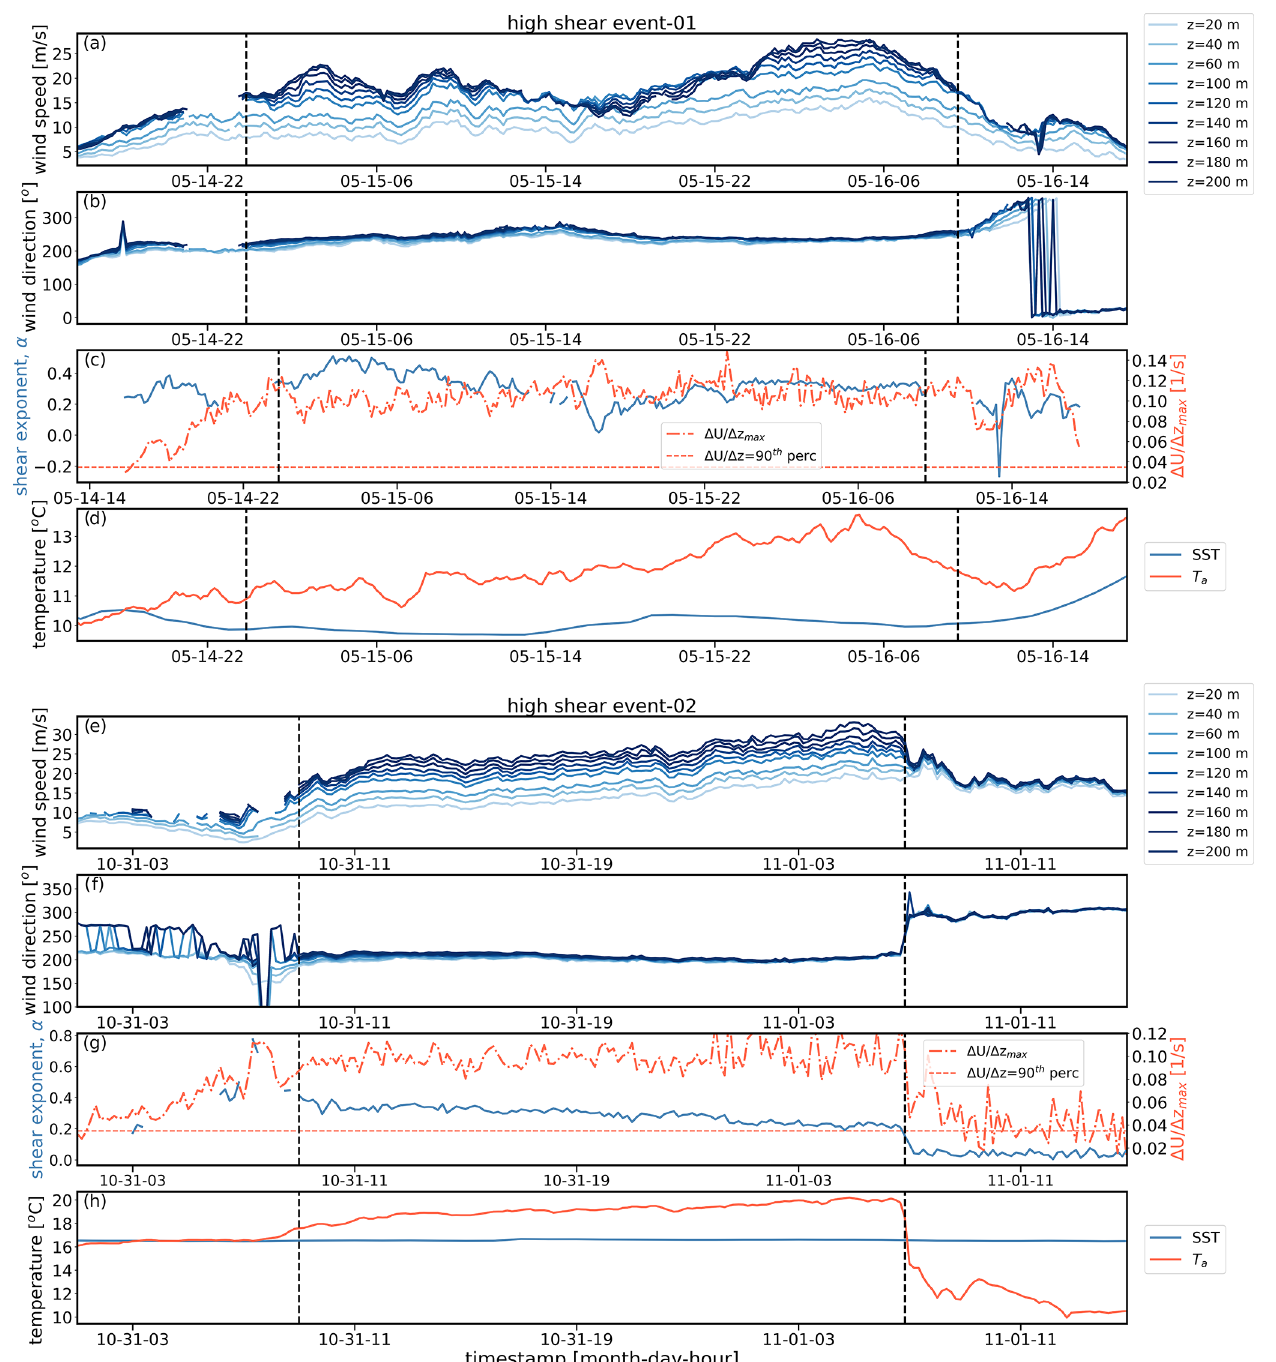
Figure 8. Two examples of high-shear events measured at the NE buoy (Table 1) in the year 2019. Panels show time series of wind speed (a, e) , wind direction (b, f) , wind shear (power-law exponent α ) and wind speed gradient ( (cid:49)U/(cid:49)z max ) (c, g) , and air ( T a ) and sea surface temperature (SST) (d, h) . Vertical dashed lines represent the start and end times of the high-shear events. First example is shown with panels (a–d) , and second example is shown in panels (e–h)